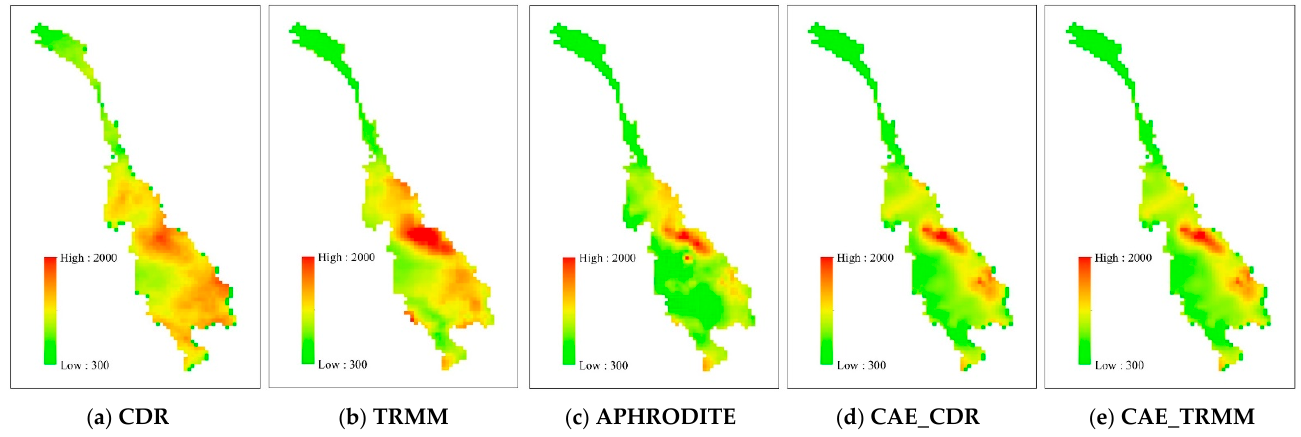
Figure 11. Spatial rainfall distribution of products over the MRB in the wet season of 2015.